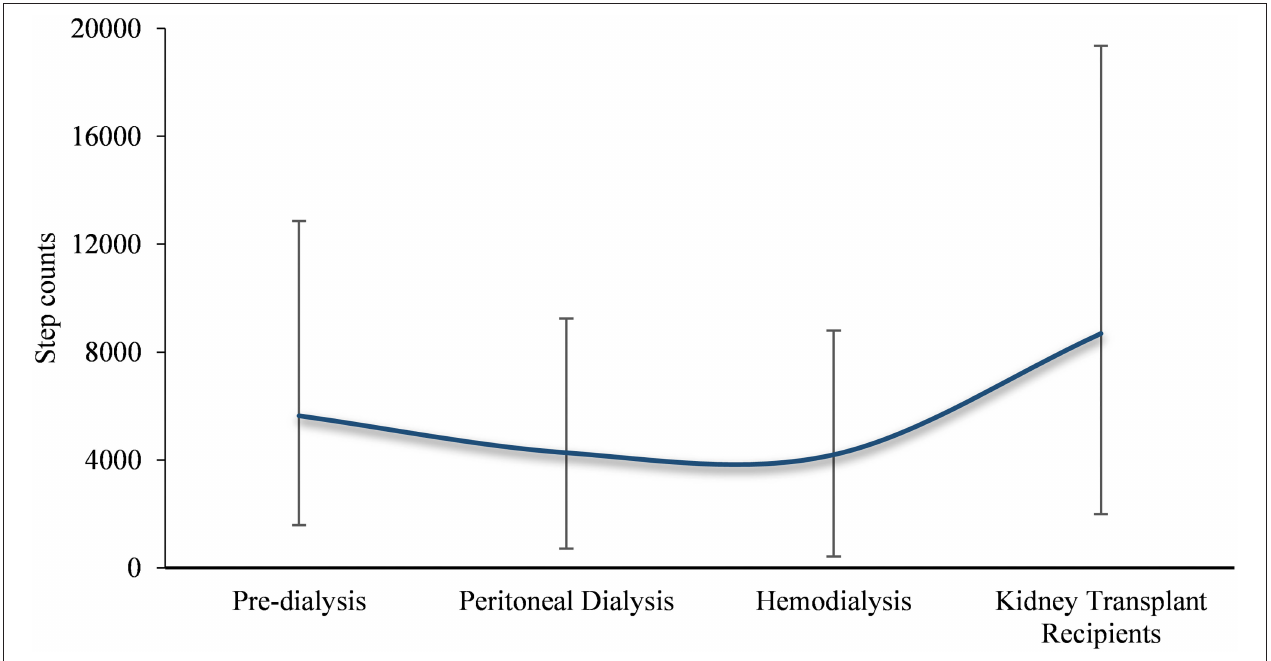
FIGURE 5 | Trends in the number of steps taken by patients with CKD.